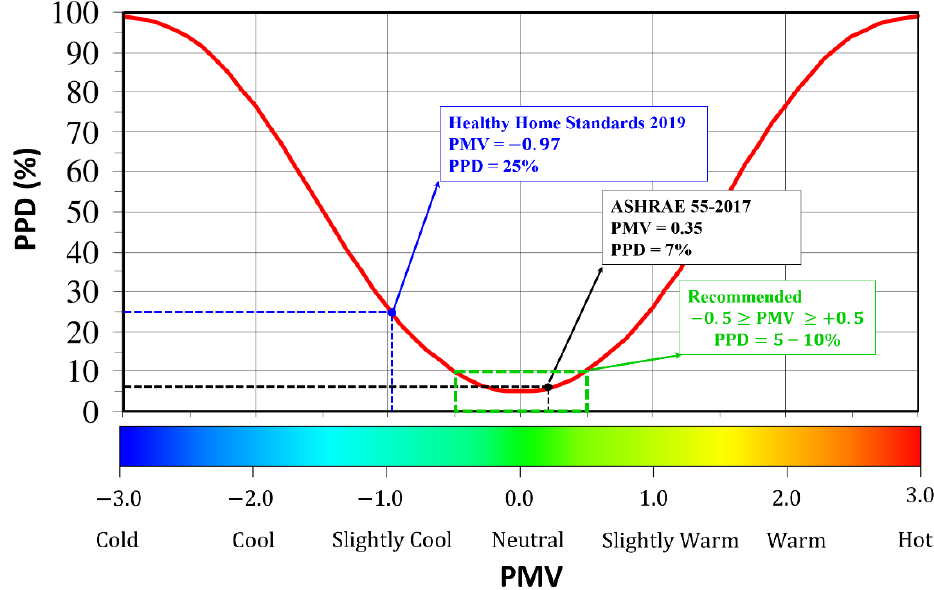
Figure 13. The PMV and PPD for the Healthy Home standards 2019 and for the ASHRAE 55-2017.